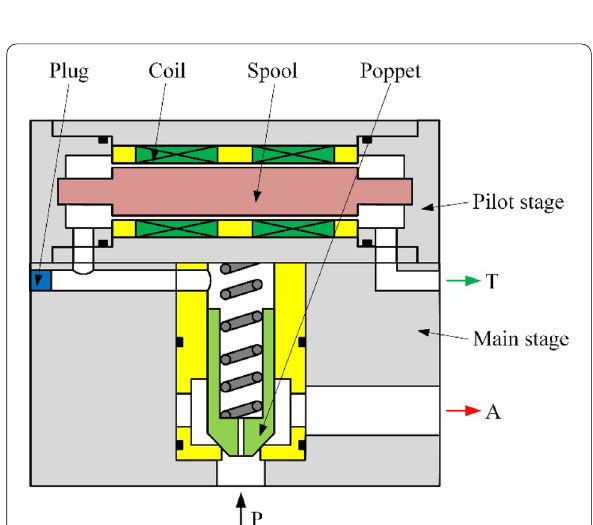
Figure 18 Pilot valve with magnetorheological fluid designed by